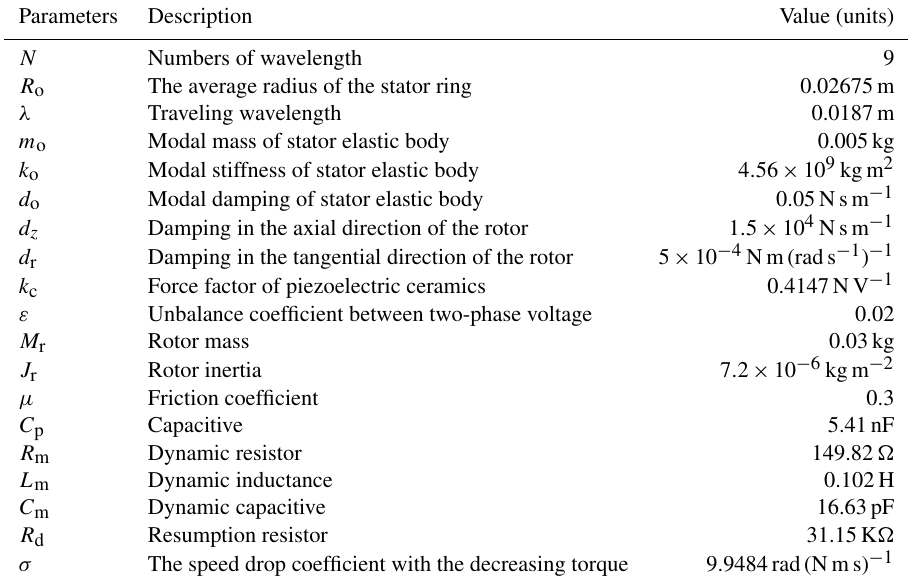
Table A1. The key simulation parameters of